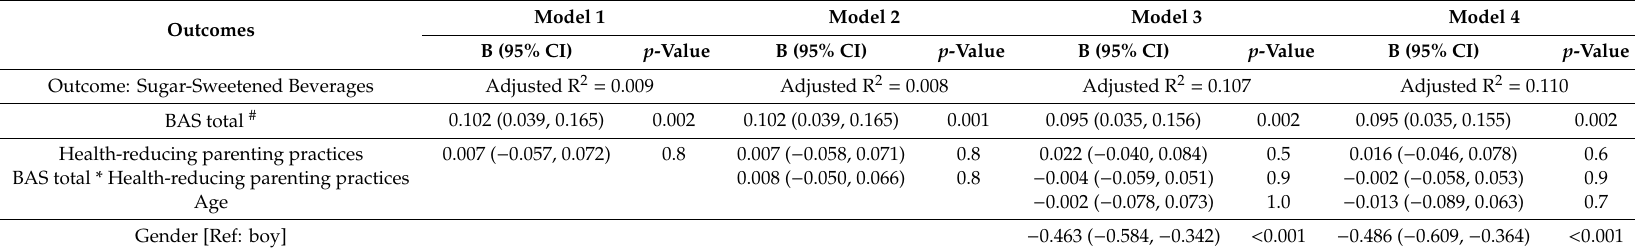
Table A2. Associations between reward sensitivity and adolescents’ intake of sugar-sweetened beverages, healthy and unhealthy snacks, and the moderating role of (adolescent-reported) Health-reducing parenting practices for all cases ( n =